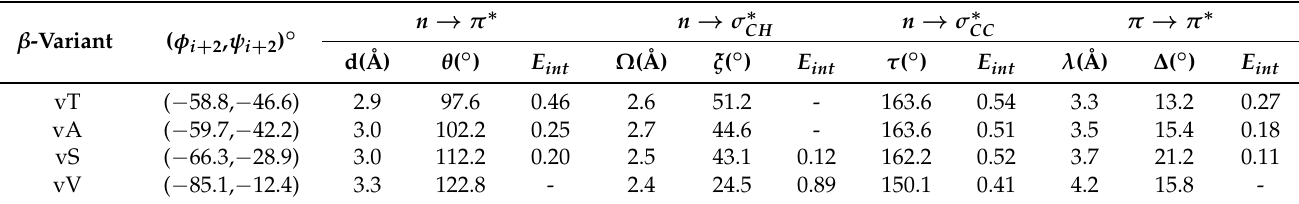
Table 2. Geometric parameters and stabilisation energies E int (kcal/mol) in the i + 1 − − i + 2 pair of residues pertaining to the β -turn long-range interactions. Refer Figure 4 for